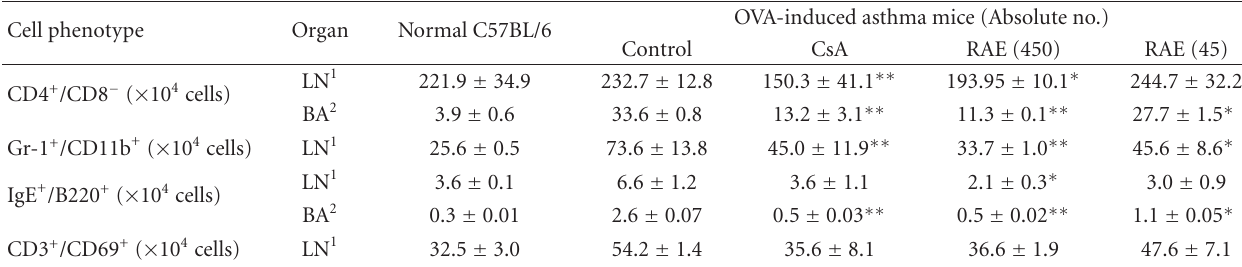
Table 2: E ff ects of RAE on CD4 + /CD8 − , GR-1 + /CD11b + , IgE + /B220 + , and CD3e + /CD69 + cells absolute number in lymph nodes and BAL fluid of OVA-induced asthma murine.